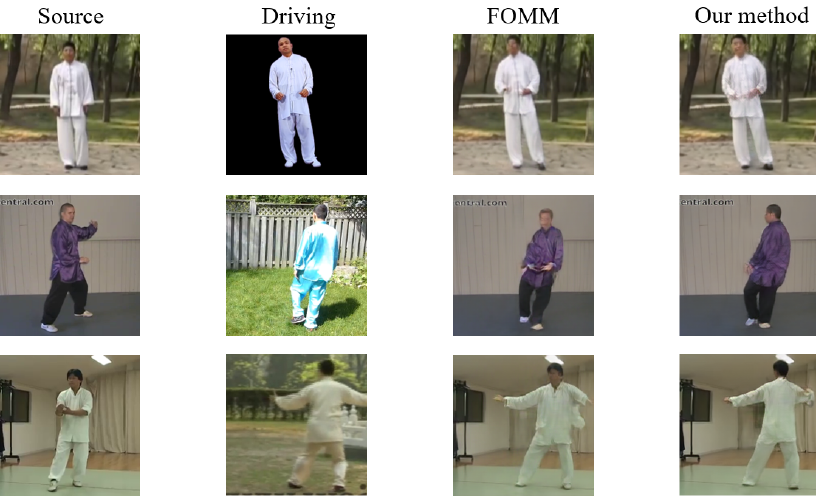
Figure 11. Comparison between our method and FOMM on the TaiChiHD dataset.